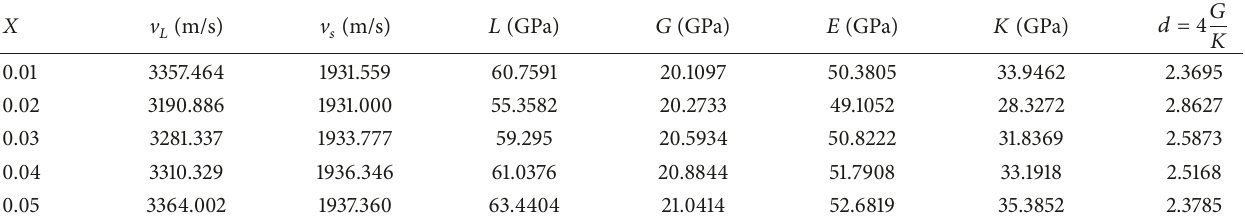
Table 3: Ultrasonic velocities (longitudinal, shear, Young’s, and bulk modulus) and fractal bond connectivity of [( TeO